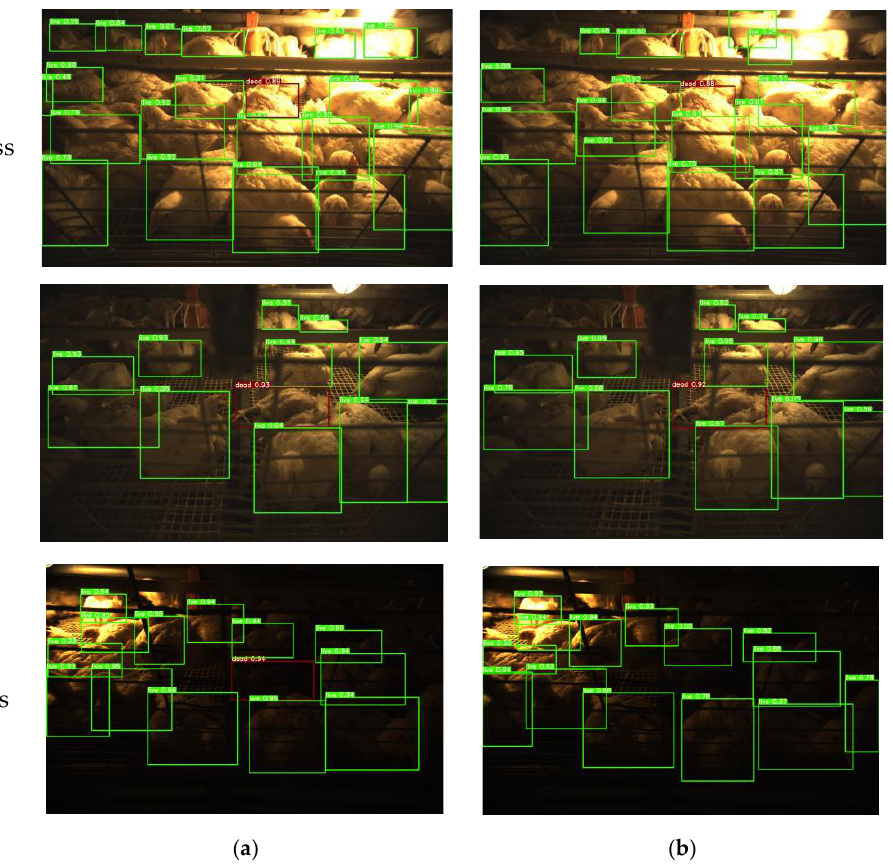
Figure 9. Test on images with different brightness. ( a ) Improved-YOLOv3. ( b ) YOLOv3 model.